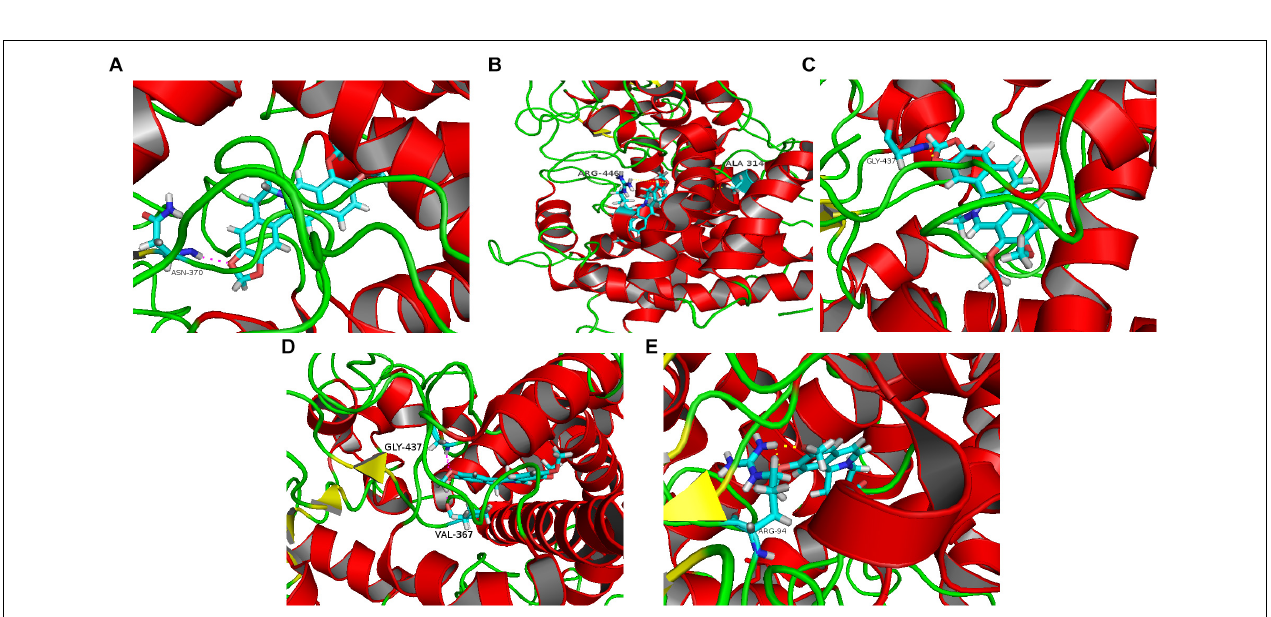
FIGURE 7 | Molecular docking analysis predicting the binding sites on CYP27A1 for the five main alkaloid components of TACS: (A) berberine; (B) palmatine; (C) chelerythrine; (D) jatrorrhizine; and (E) dehydrocavidine.